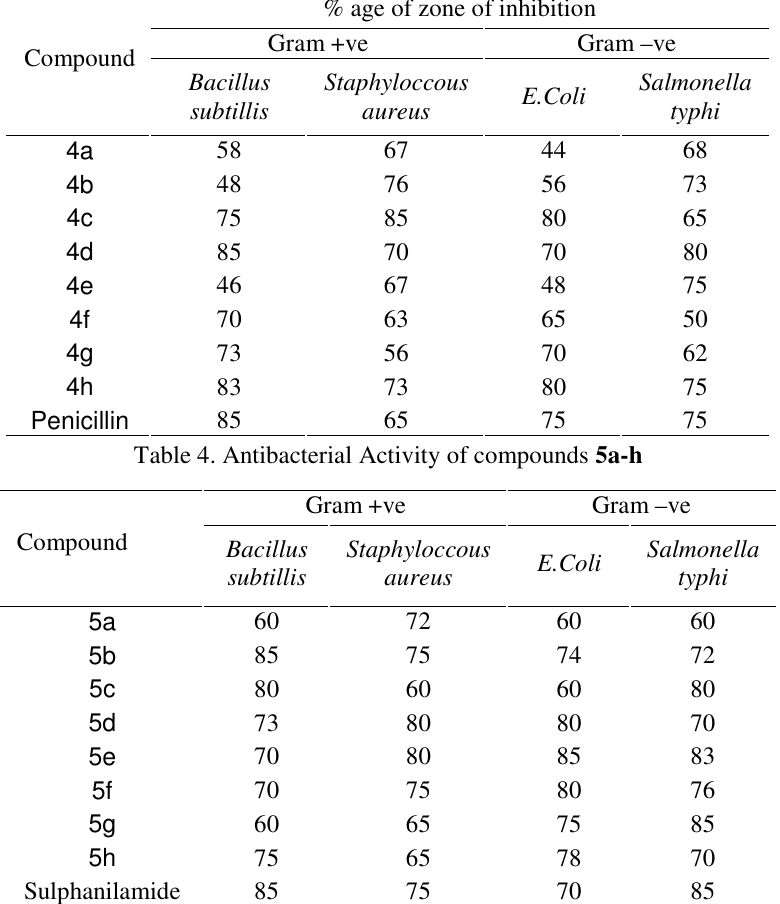
Table 3 . Antibacterial Activity of compounds 4a-h